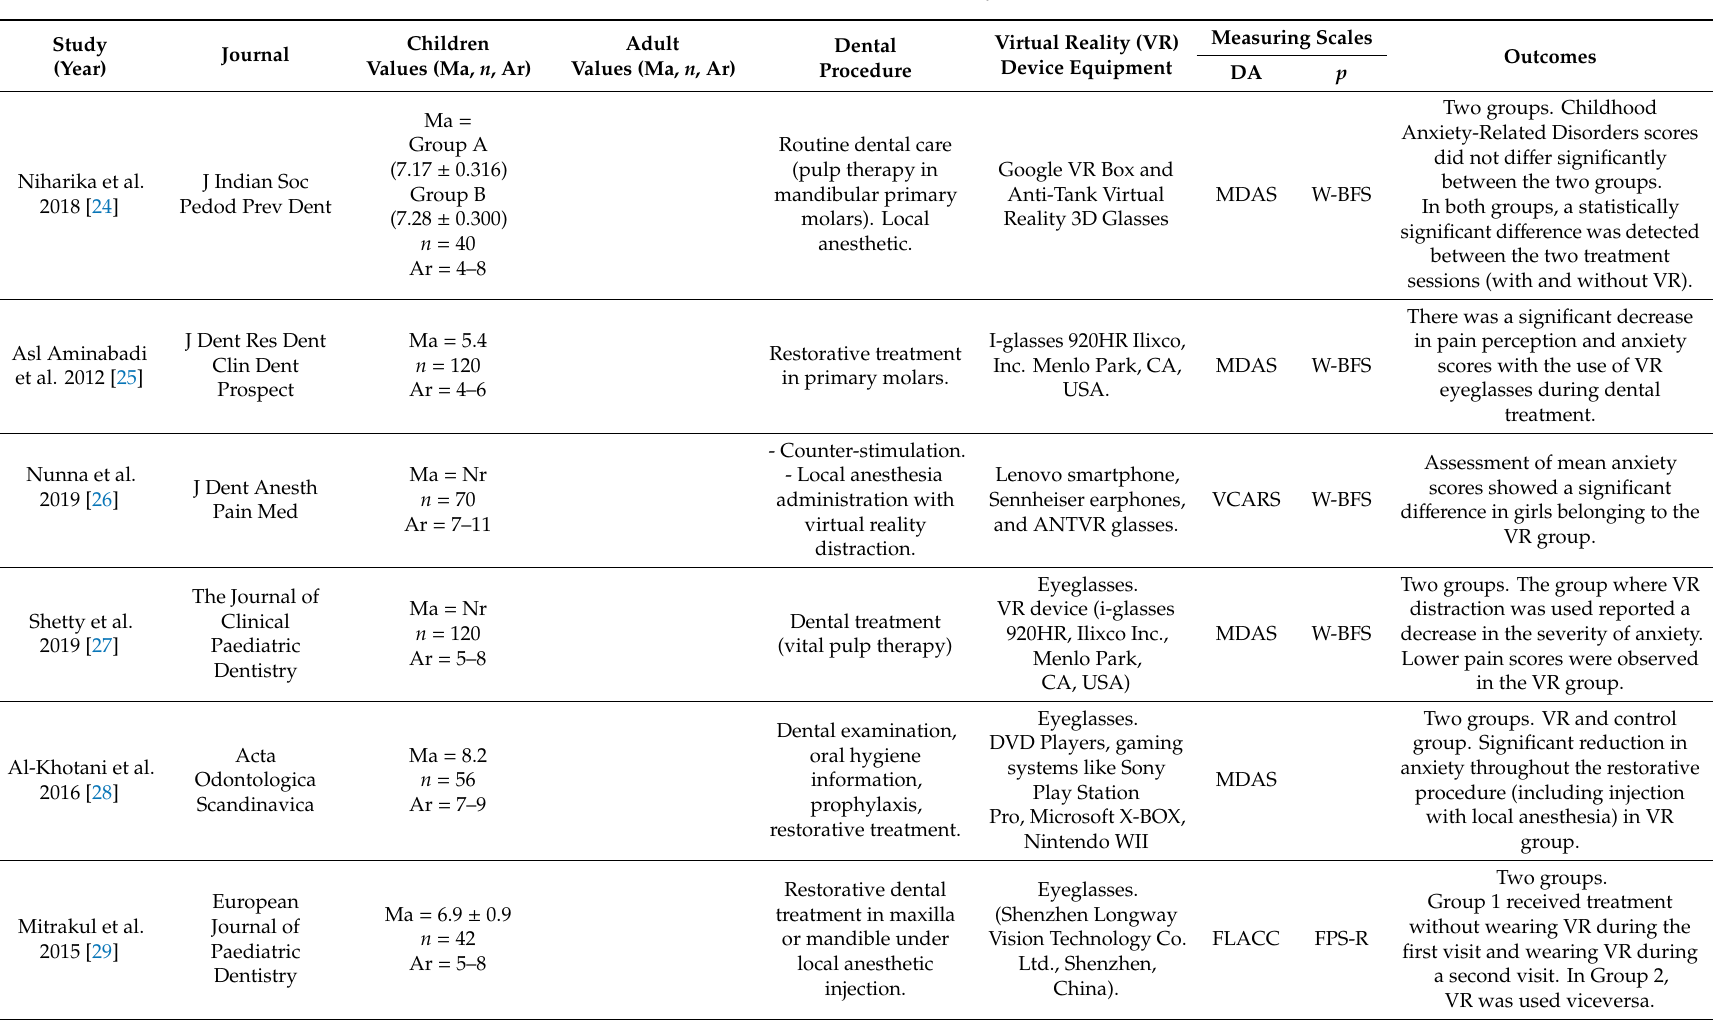
Table 1. Details of each